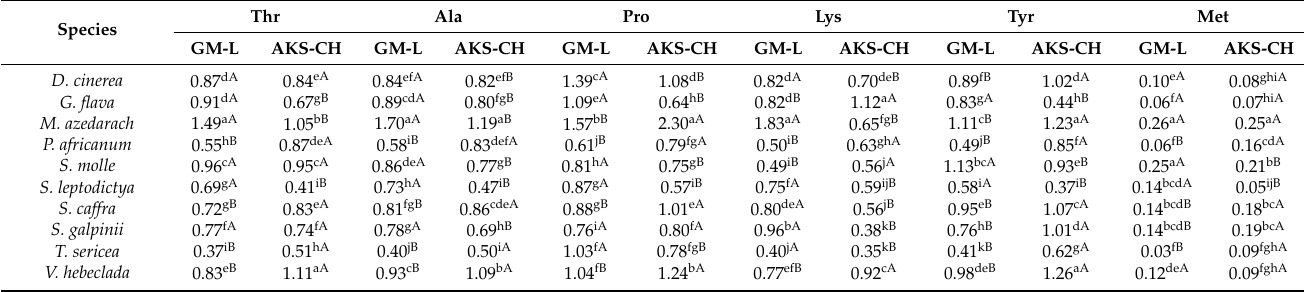
Table 6. Effect of species and soil type on Thr, Ala, Pro, Lys, Tyr and Met (g/100 g sample) of browse species found in GM-L and AKS-CH soil